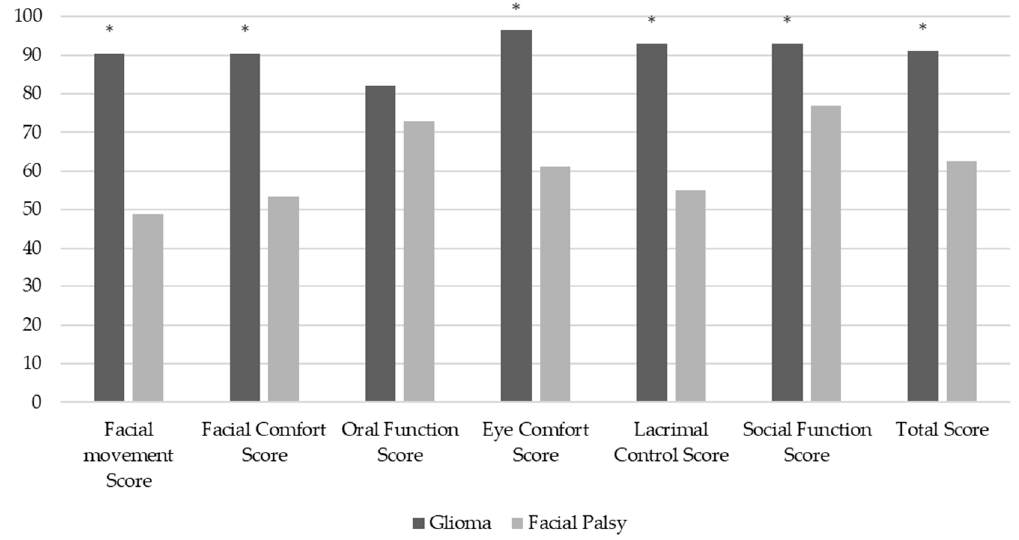
Figure 2. Postoperatively, the glioma group had significantly better QoL scores regarding dimensions affected by facial motor dysfunction in all domains, except oral function, as compared to patients with facial palsy [32]. * = p ≤ 0.05.